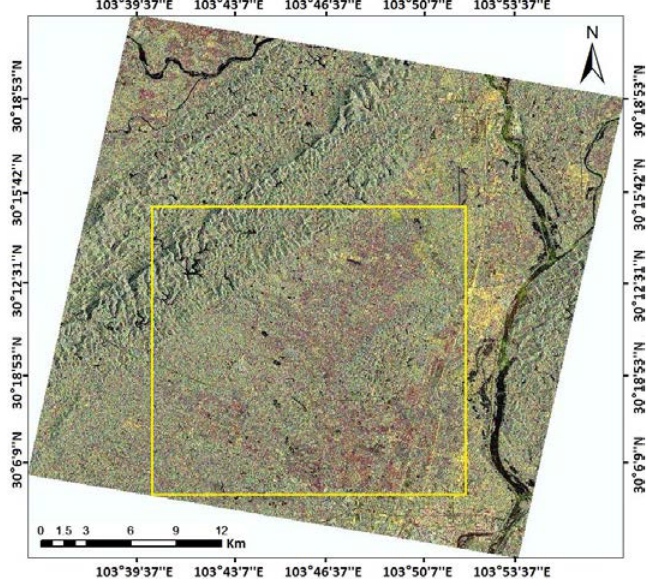
Figure 4. A RADARSAT-2 image acquired on 2 July 2016. VH, VV, and HH bands were assigned as red, green, and blue colors, respectively. Study area is within the yellow box.